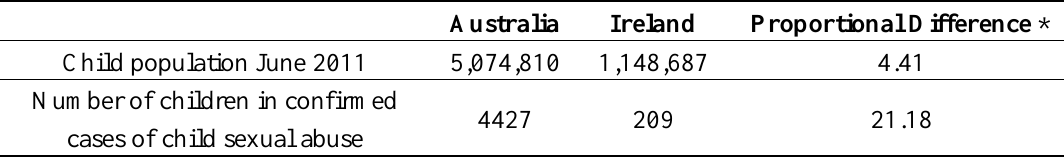
Table 2. Number of children aged 0–17 in confirmed cases of child sexual abuse, Australia and Ireland,